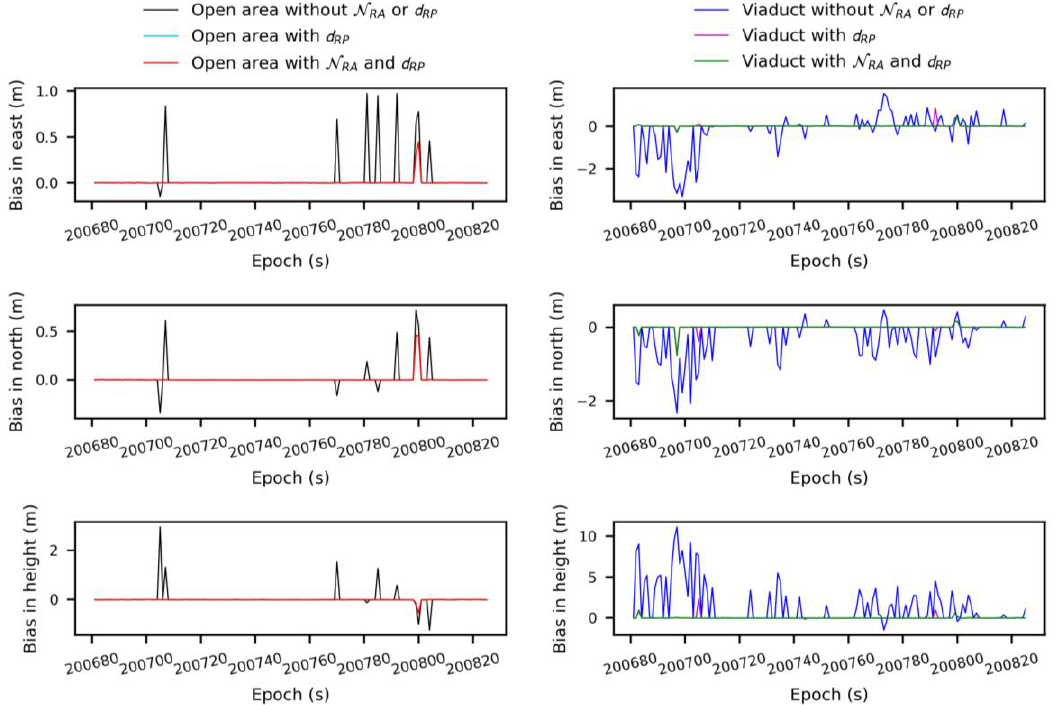
Figure 10. Positioning errors in east, north and height directions of the vehicle 1 in the absolute positioning for six cases.